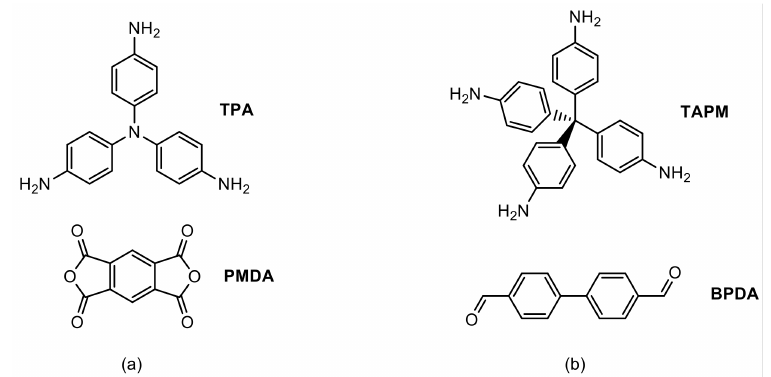
Figure 1. Structures of ( a ) PI-COF and ( b ) COF-320 building